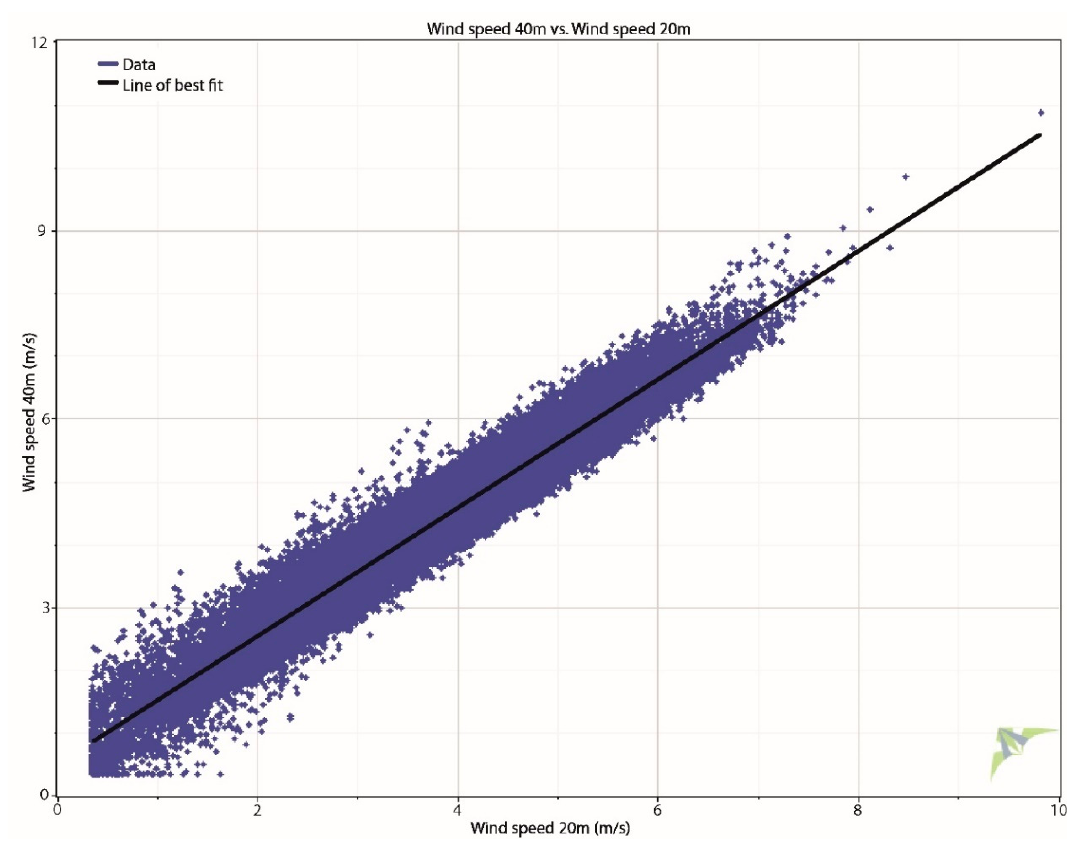
Figure 7. Correlation between wind speed values from different anemometers at 40 and 20 m height. Source: generated by the software.